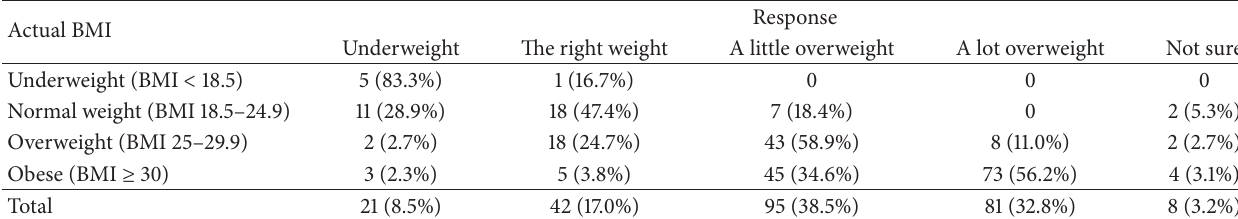
Table 3: Descriptive weight perception compared between the BMI groups ( 𝑃 < 0.001 ).